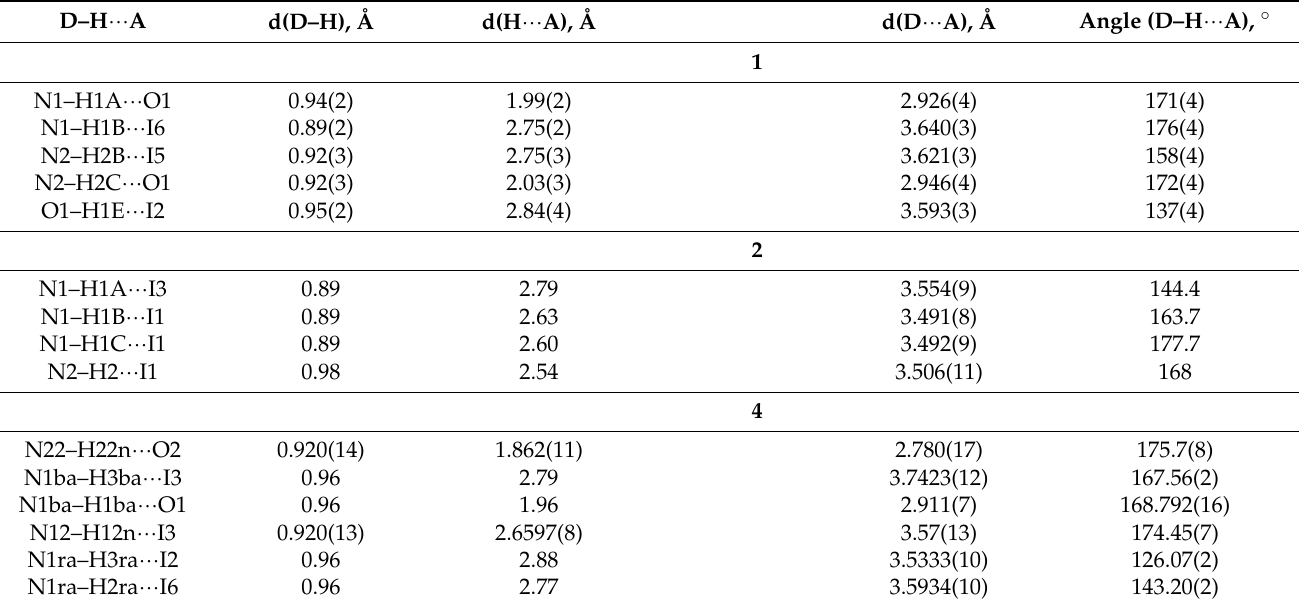
Table 2. Hydrogen Bonding in the Crystal Structures of 1 , 2 , and 4